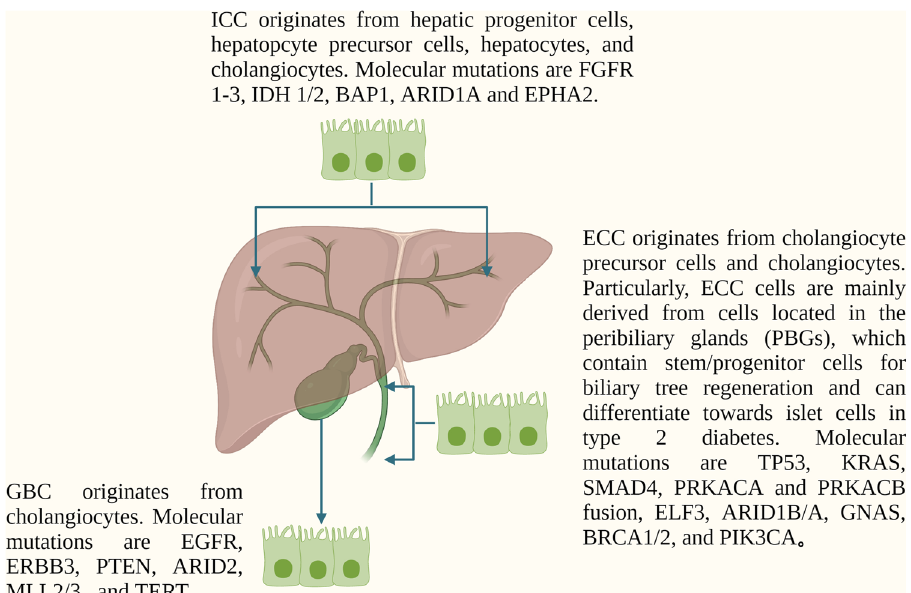
Fig. 2 Cell of origin and molecular alterations of three subtypes of BTC. The difference in the cell of origin and molecular alterations lays the foundation of the risk discrepancy between insulin and three subtypes of BTC. Compared to ICC and GBC, ECC originates mainly from cells residing in PBGs and has more frequent mutations in P53, KRAS, and SMAD4, resulting in greater sensitivity to insulin stimulation. BTC biliary tract cancer, ICC intrahepatic cholangiocarcinoma, ECC extrahepatic cholangiocarcinoma, GBC gallbladder cancer, PBGs peribil- iary glands, FGFR 1–3 fibroblast growth factor receptor 1–3, IDH 1/2 isocitrate dehydrogenase, BAP1 BRCA1-associated-protein 1,ubiquitin carboxyl-terminal hydrolase, ARID1A AT-rich interactive domain-containing protein 1 A, EPHA2 ephrin type-A receptor 2, TP53 tumor pro- tein P53, KRAS kirsten rat sarcoma viral oncogene homolog, SMAD4 mothers against decapentaplegic homolog 4, PRKACA protein kinase cyclic adenosine monophosphate (cAMP)-activated catalytic subunit alpha, PRKACB protein kinase cAMP-activated catalytic subunit beta, ELF3 E74 like ETS transcription factor 3, ARID1B/A AT-rich interactive domain-containing protein 1 B/A, GNAS guanine nucleotide-binding protein-alpha stimulating, BRCA1/2 breast cancer gene 1/2, PIK3CA phosphatidylinositol-4,5-bisphosphate 3-kinase catalytic subunit alpha, EGFR epidermal growth factor receptor, ERBB3 erythroblastic leukemia viral oncogene homologue3, PTEN phosphatase and tensin homolog, ARID2 AT-rich interactive domain 2, MLL2/3 histone-lysine N-methyltransferase, TERT telomerase reverse transcriptase. (Fig. 2 is created with